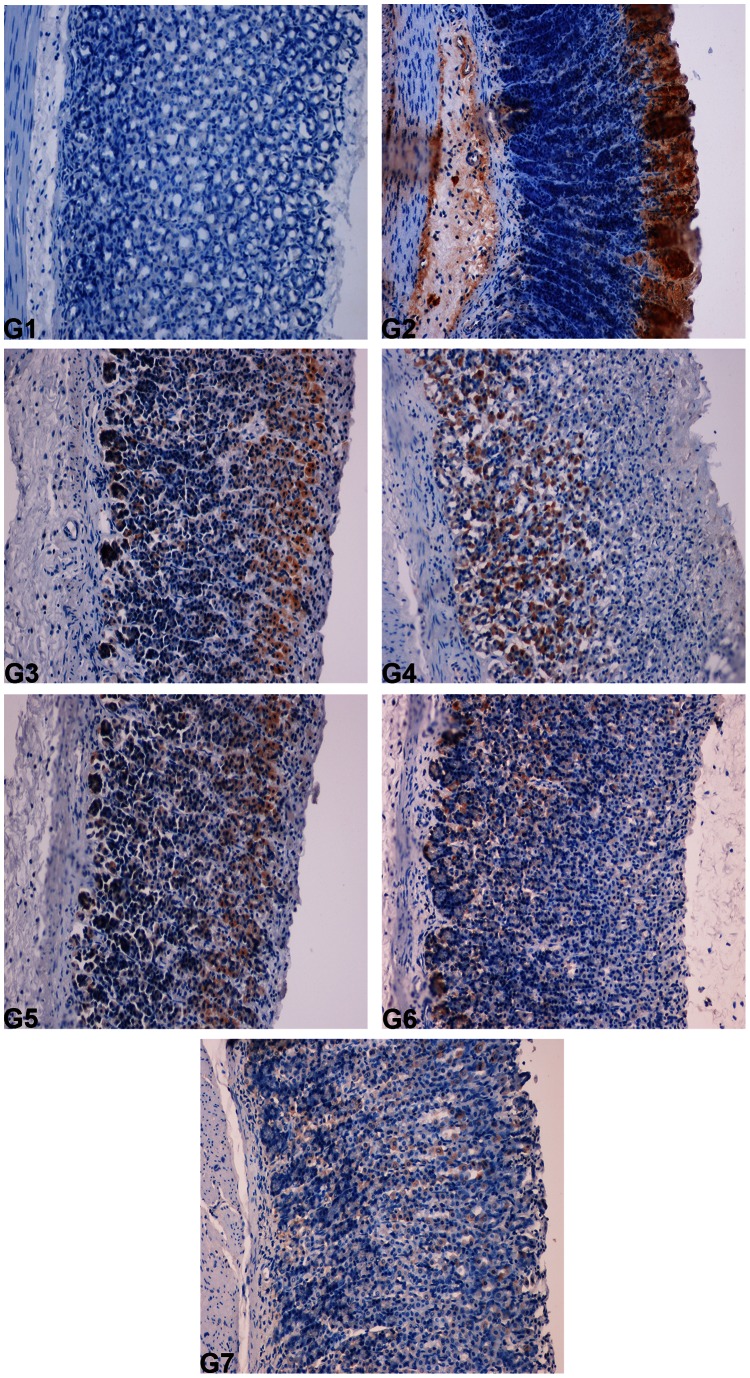
Immunohistochemical analysis of the expression of the BAX protein in the gastric mucosa of rats.(G1) (Normal control group); (G2) (Ulcer control group); (G3) (Omeprazole); (G4) (50 mg/kg), (G5) (100 mg/kg), (G6) (200 mg/kg), (G7) (400 mg/kg) Parkia speciosa extract. BAX protein expression was downregulated in rats pretreated with Parkia speciosa (magnification 20×).